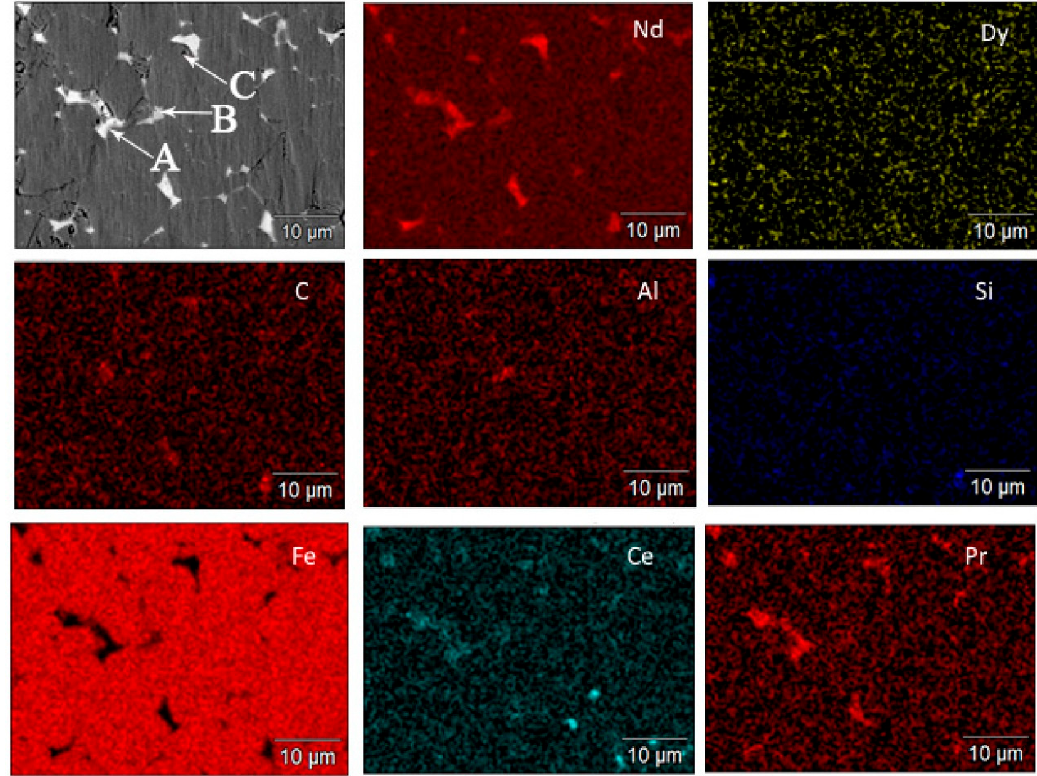
Figure 7. High-resolution EDX mapping of the NdFeB magnet scrap [60]; published by Elsevier, 2020.